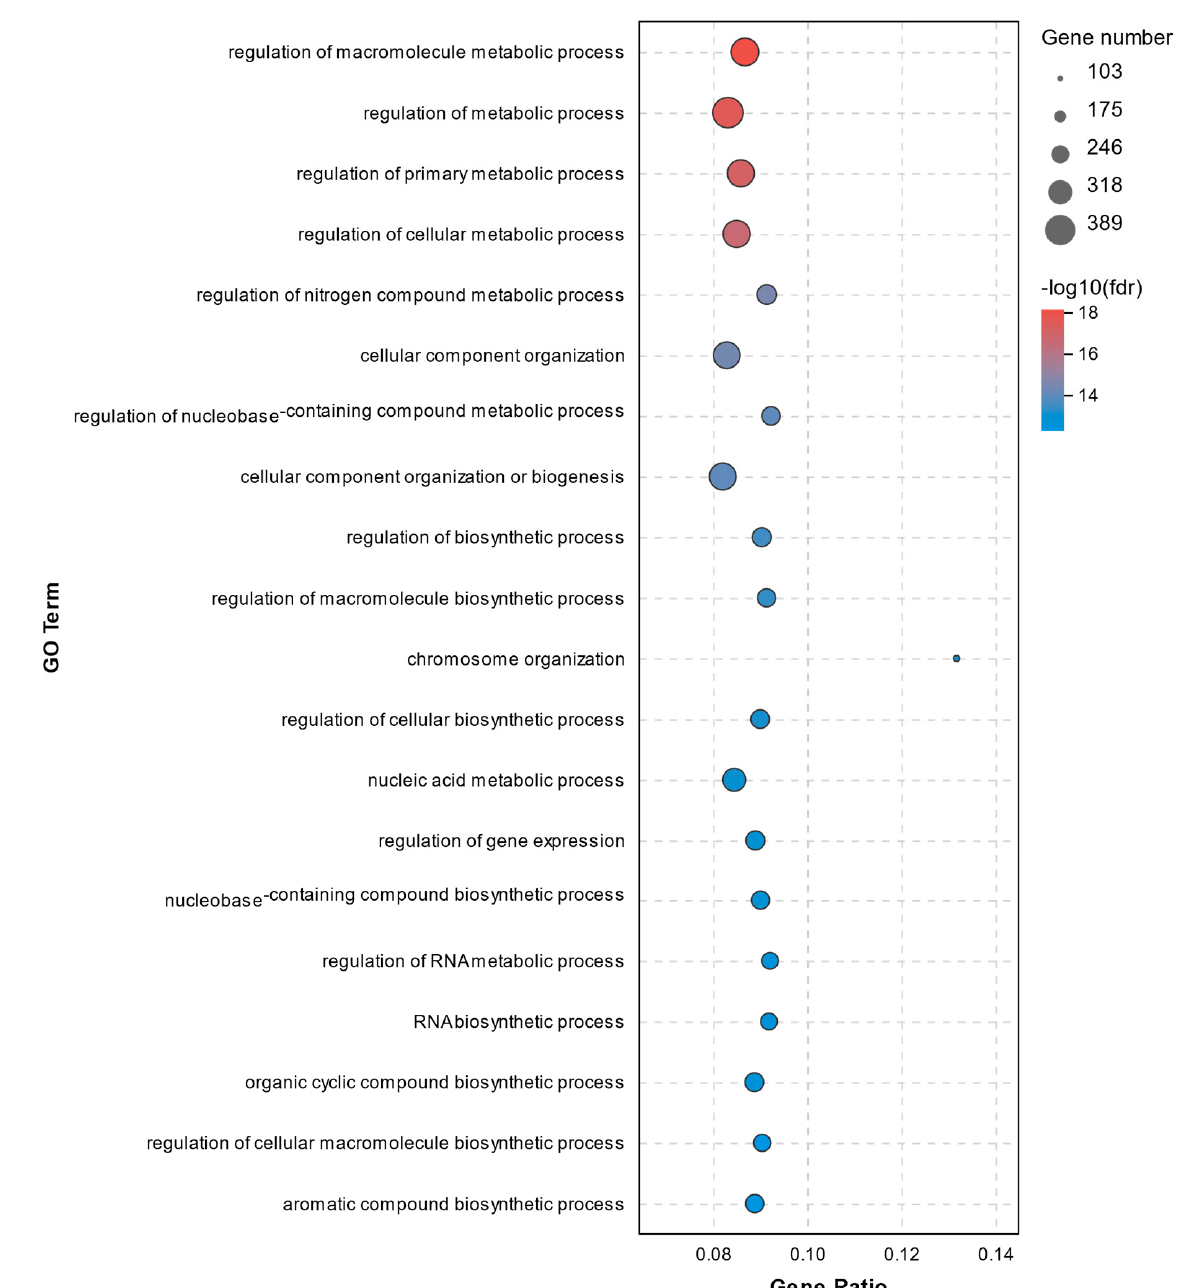
Figure 5. Top20 GO terms for DEGs between the C1 and C2 groups.